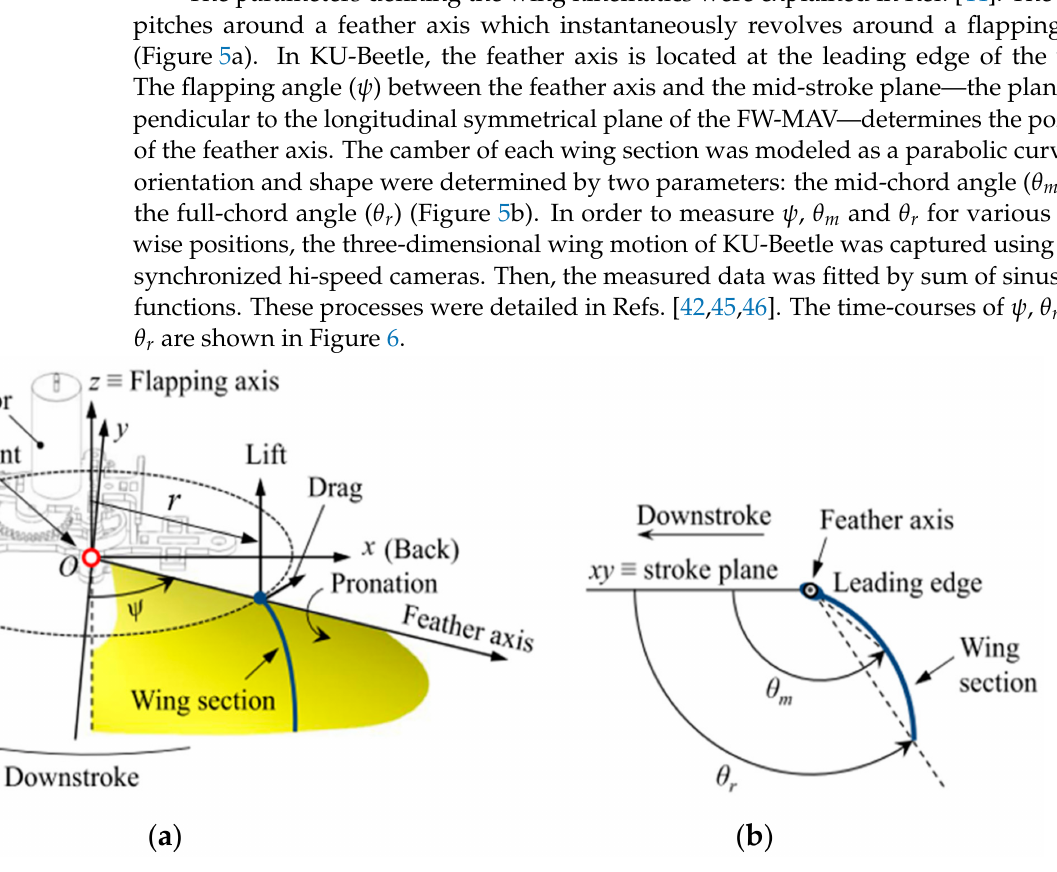
Figure 5. Definitions in the flapping-wing motion. ( a ) Feather axis, flapping axis, and flapping angle ψ ; ( b ) The parabolic curve modeling camber of a wing section. Reprinted from Ref.